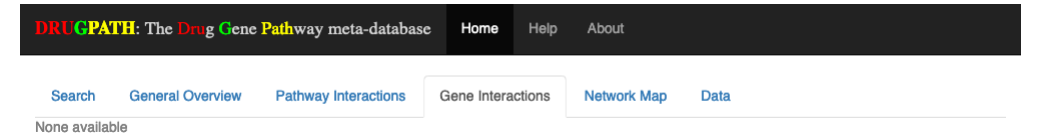
Figure 9. Message that appears when no gene interactions are